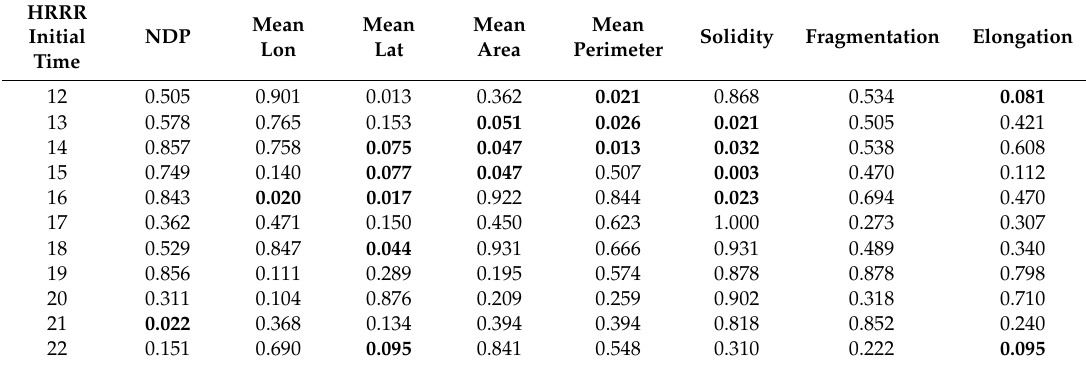
Table 3. Mann–Whitney U p -values for 6.35 mm h − 1 (0.25 in h − 1 ) threshold for Jul 31, 2016 case. Bold font face indicates significance at 90% confidence threshold.